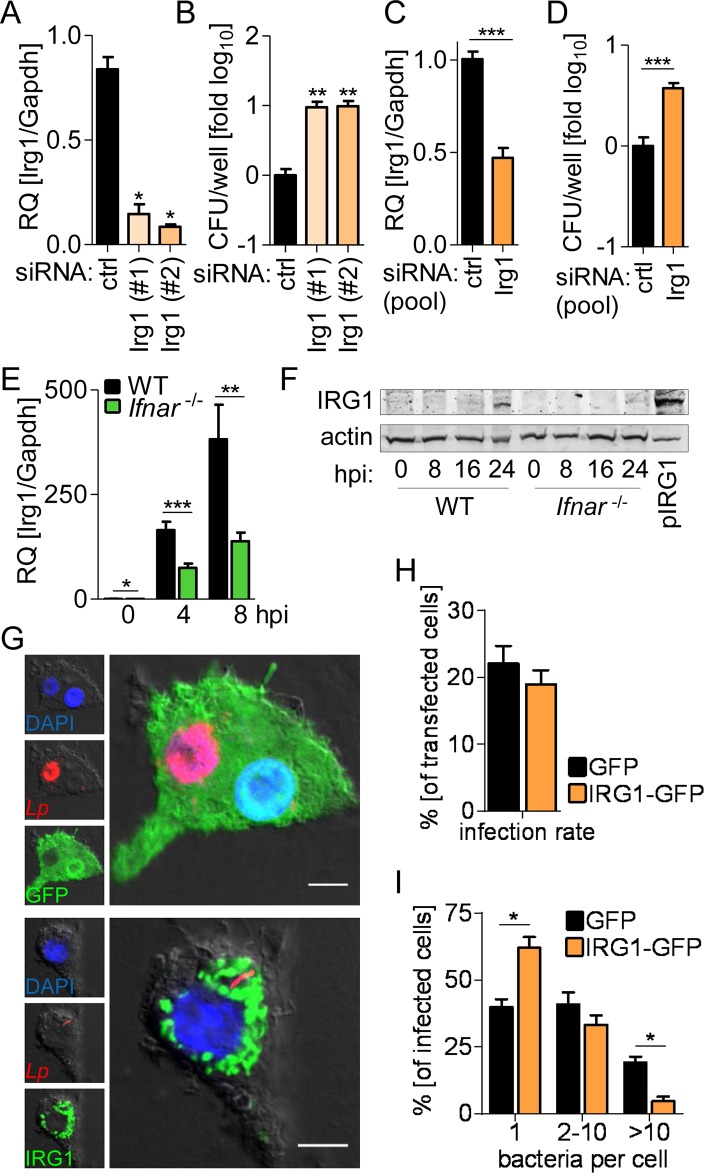
IRG1 is regulated by IFNs and restricts L. pneumophila within their vacuoles.(A-D) BMMs (A, B) or alveolar macrophages (C, D) were transfected with control or two IRG1 siRNAs separately (A, B) or pooled (C, D), infected with L. pneumophila, Irg1 expression was assessed 24 h p.i. (A, C), and CFUs were counted 72 h p.i. (B, D). (E, F) Irg1 gene and IRG1 protein expression in WT and Ifnar
-/- BMMs upon infection with L. pneumophila was determined at indicated time points by qRT-PCR (E) and western blot (F). Cells overexpressing IRG1-Myc-DDK (pIRG1) were loaded as a positive control (F). (G-I) Ifnar
-/- BMMs overexpressing IRG1-GFP or GFP only were infected with DsRed-expressing L. pneumophila (red). Cells were fixed 24 h p.i., representative images taken (G), and overall infection rate (H) as well as number of intracellular bacteria per cell determined by manual counting (I). (G) Scale bars indicate 5 μm. Data are mean + s.e.m. of 2 (A, B) or 4 (E) independent experiments done in triplicates or 3 independent experiments done in quadruplicates (C, D). * p<0.05, ** p<0.01, *** p<0.001, no indication if not significant (Mann-Whitney U test). (F) Representative blot of 3 independent experiments. (H, I) > 100 GFP- / IRG1-GFP-expressing cells were counted manually for intracellular bacterial numbers, data represent mean + s.e.m. of 2 independent experiments done in duplicates * p<0.05, no indication if not significant (Mann-Whitney U test).